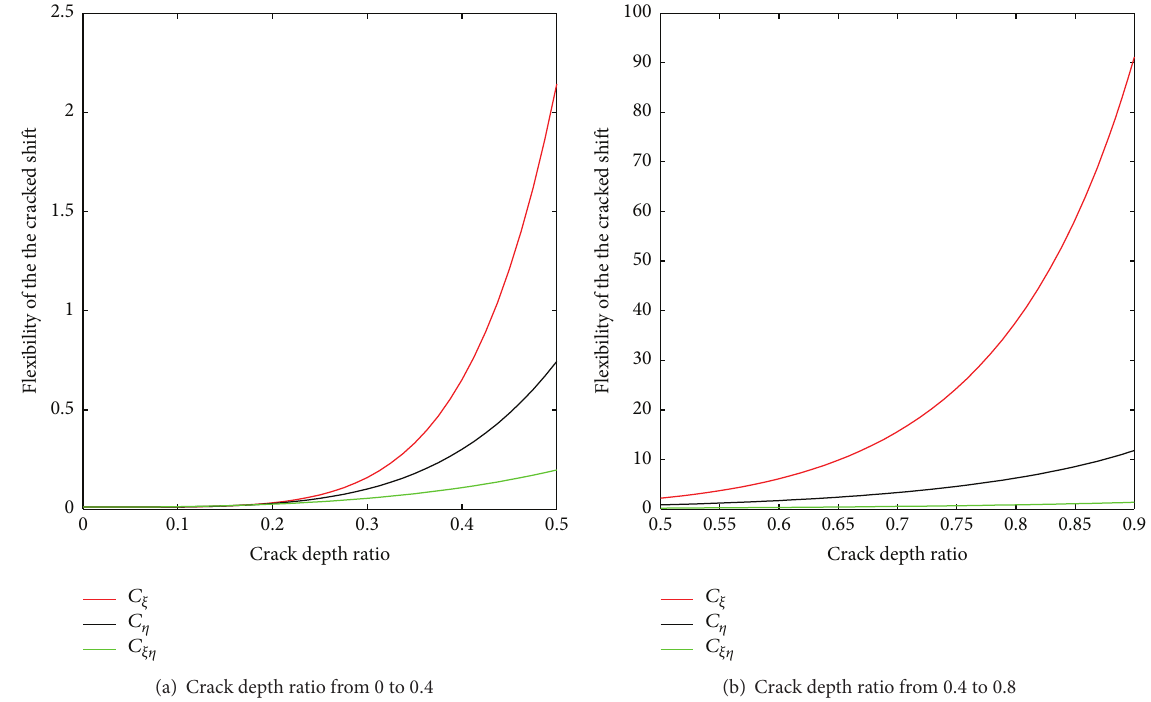
Figure 4: The flexibility-crack depth ratio